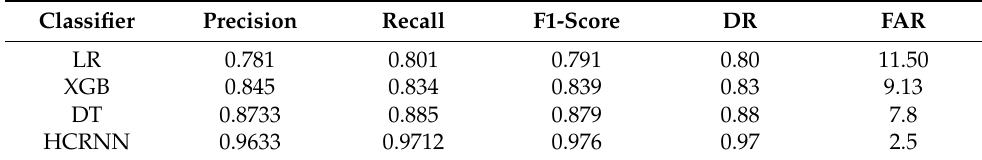
Table 5. Classifier performance with